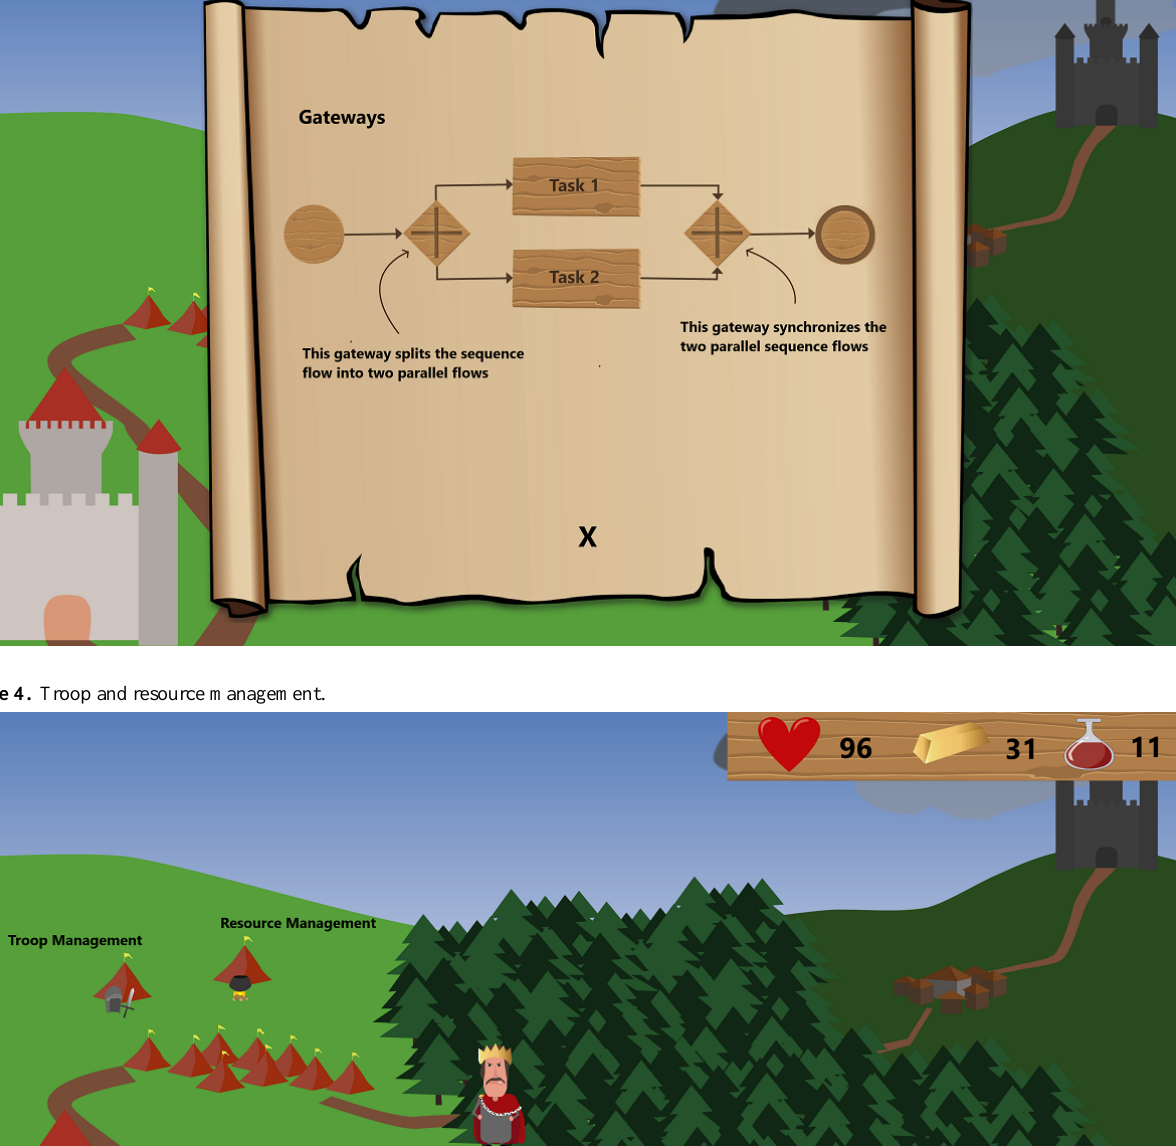
Figure 3. Description and help text.